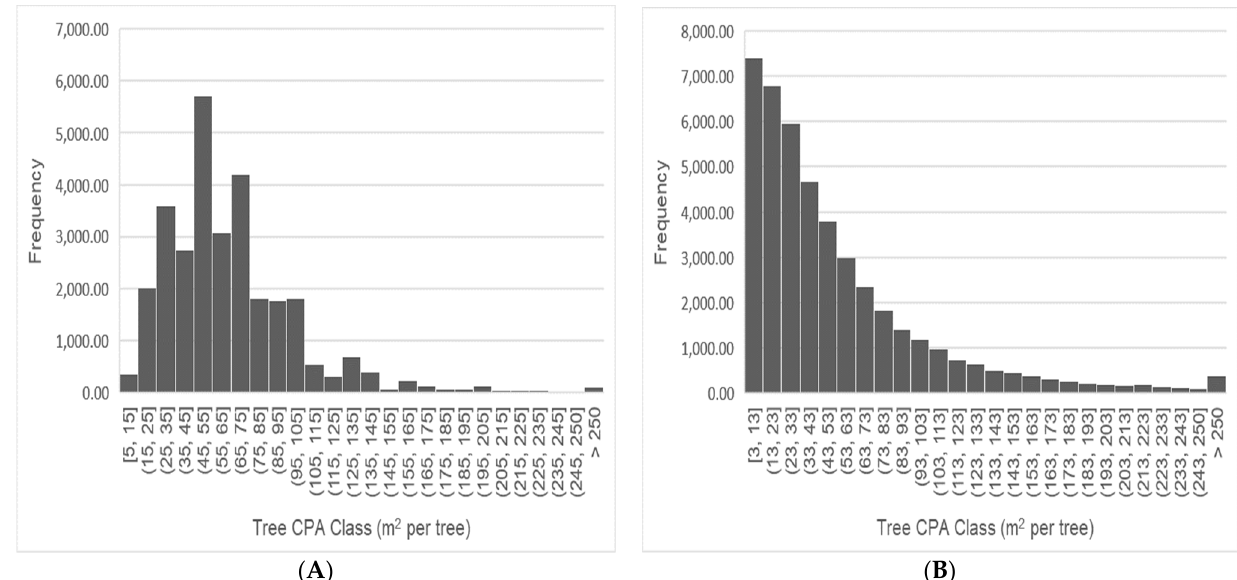
Figure 8. Size class distribution of mapped CPA. ( A ) The distribution of the number of individual trees from this study by class of tree-CPA (m 2 ) and ( B ) comparison with the automated mapping from Brandt et al. Both the number of trees overall and the shape of the distribution differed, with the highest frequency class for this analysis centered on medium size trees while considerably more small trees were mapped by Brandt et al.